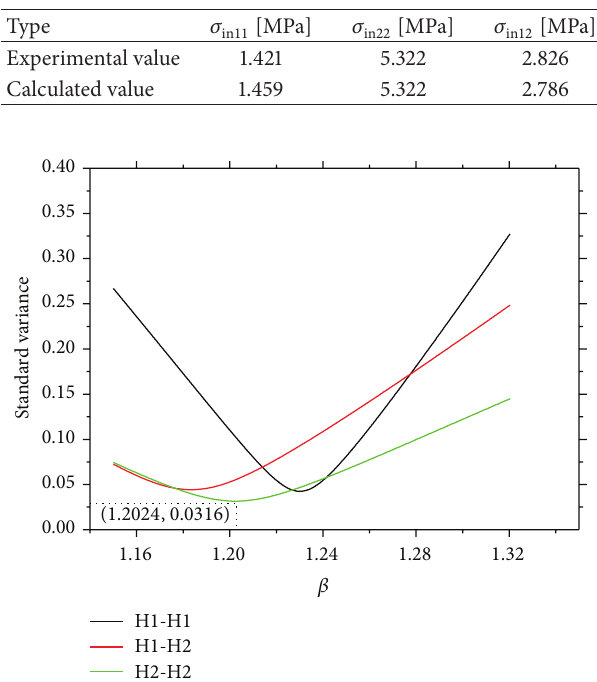
Table 4: Inserting stress of H1 and H2.